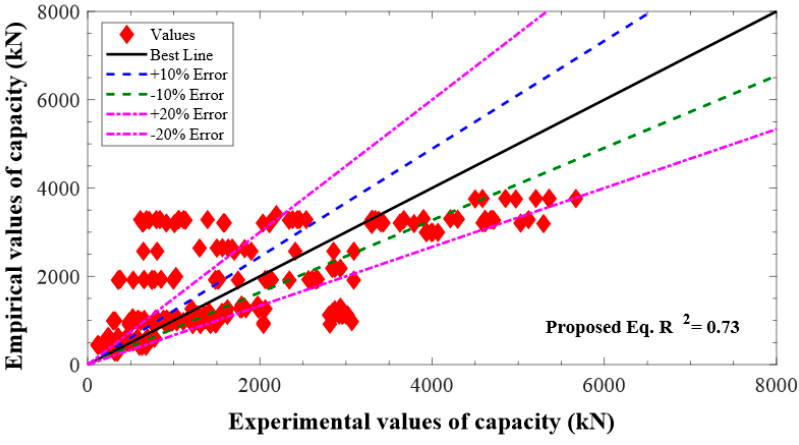
Figure 3. Performance of the suggested model.